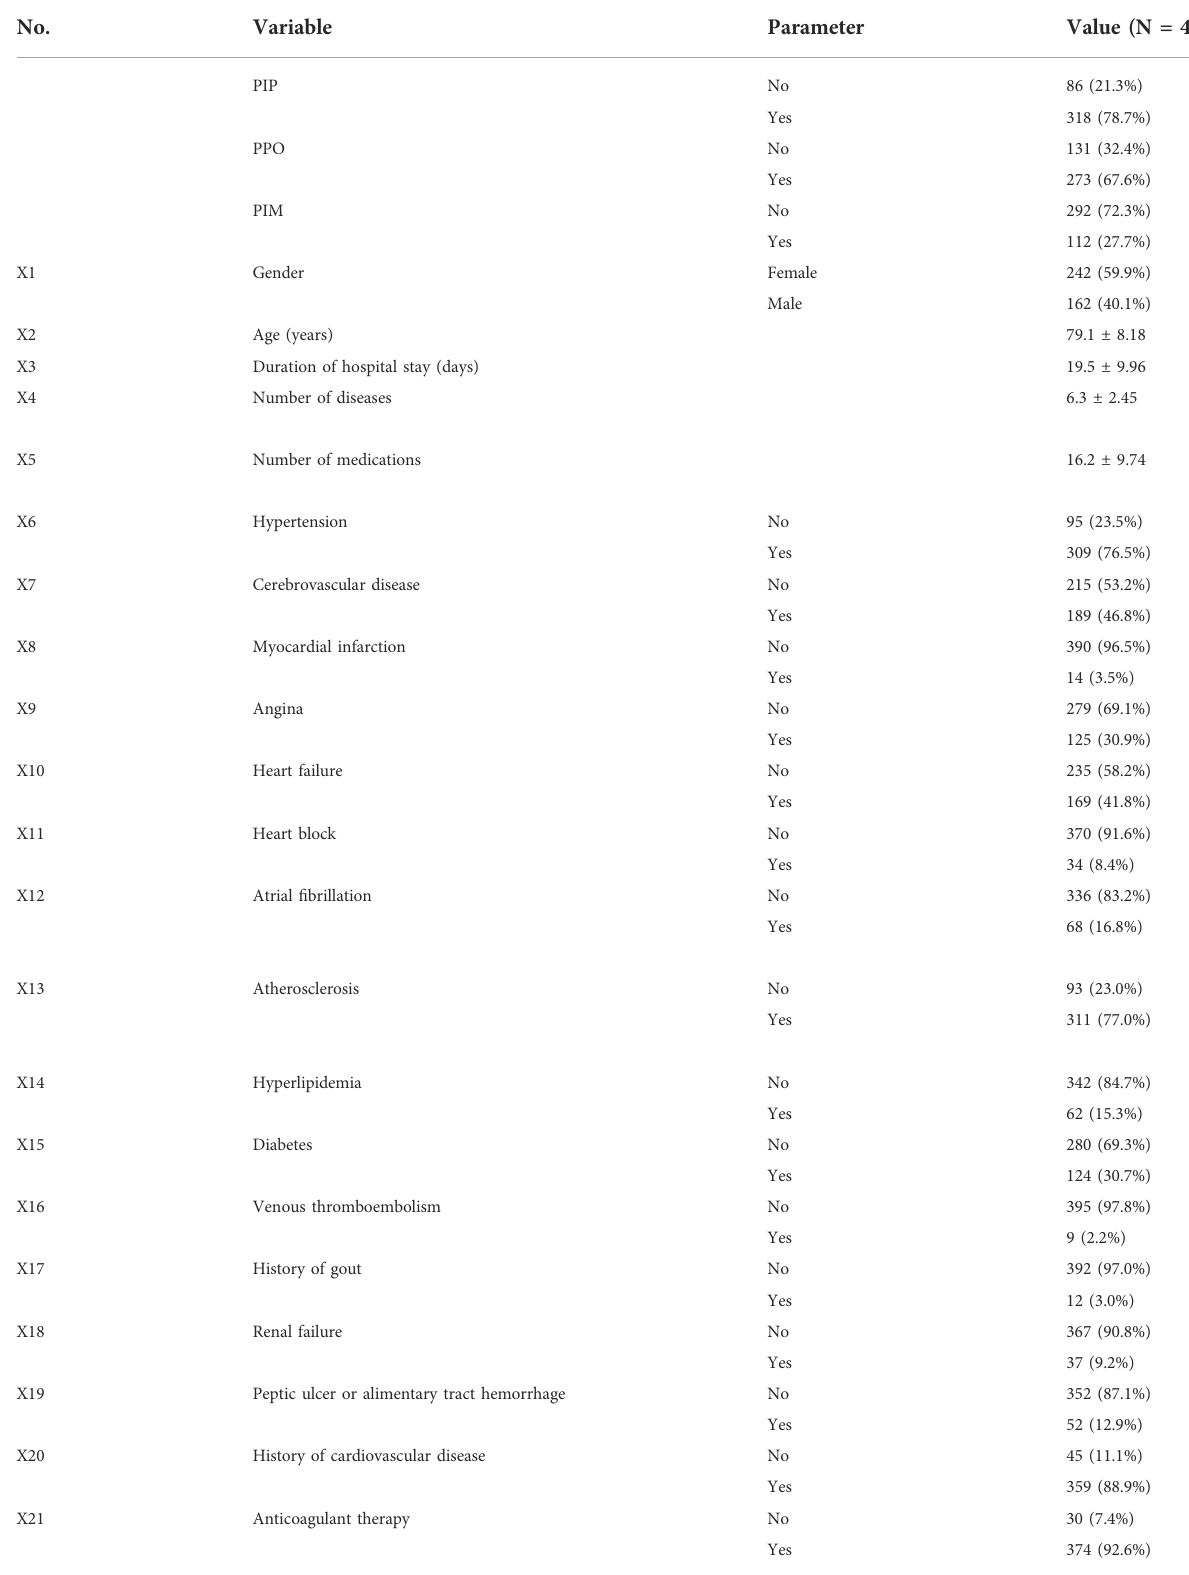
TABLE 1 Information of PPO, PIP, PIM, and characteristics in the participants.